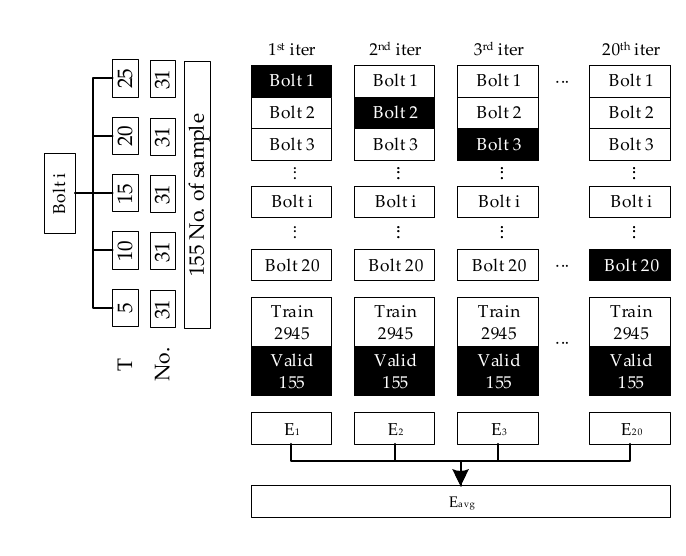
Figure 12. Model evaluation process. Each bolt contained 155 samples from five different torque values (T, torque, No., number of samples). Twenty iterations corresponding to 20 models were used for training, and the validation was on 19 bolts and 1 bolt, respectively. E, Error at each model; Eavg, averaged error used for model